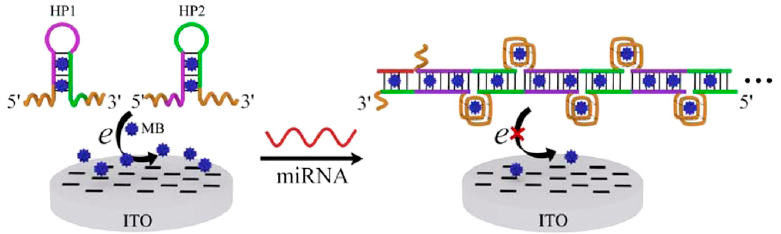
Figure 15. Mechanism of the label-free and enzyme-free homogeneous electrochemical strategy based on HCR amplification for miRNA Assay [116] Copyright 2015. Reproduced with permission from American Chemical Society.